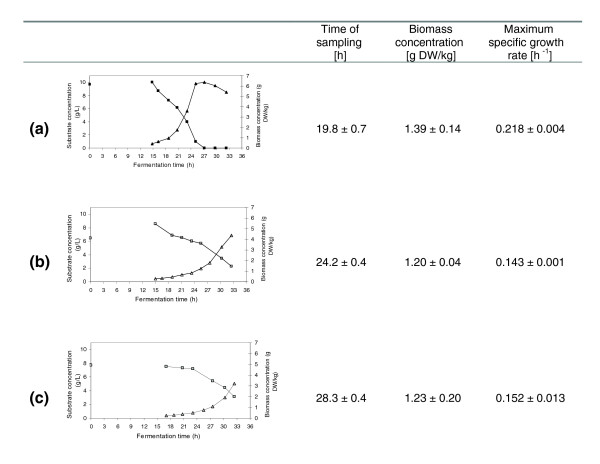
Biomass and substrate profiles for the different batch cultivations carried out with A. nidulans. (a) Cultivation with glucose as carbon source. (b) Cultivation with glycerol as carbon source. (c) Cultivation with ethanol as carbon source. For all cultivations, the time of sampling, the biomass concentration at the time of sampling, and the maximum specific growth rate for the culture are given.